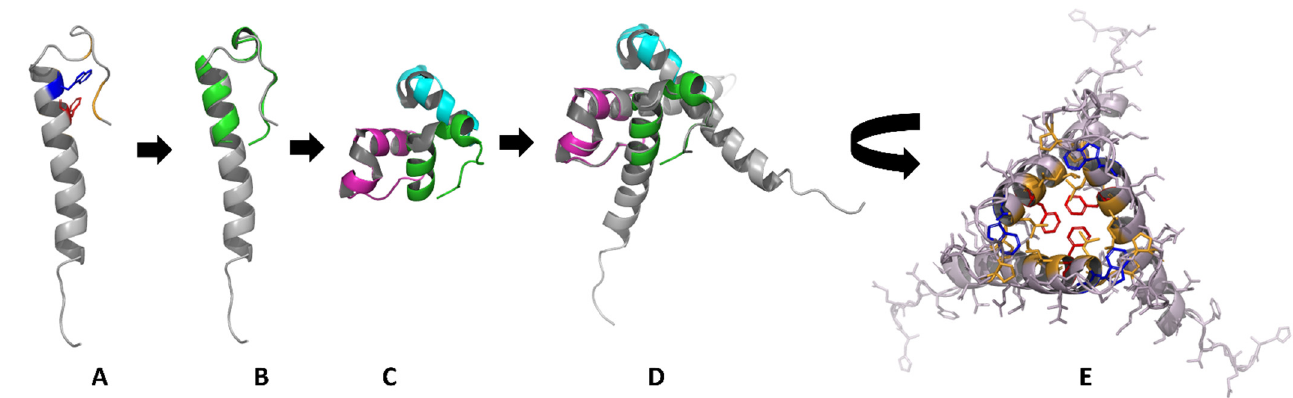
Figure 3. Structural hypothesis on the self-assembly of exendin-4. ( A ) NMR structure of exendin-4 in 30% TFE (PDB 1JRJ) with the conserved hydrophobic domain shown in colors (red Phe22, blue Trp25, orange Pro31, Pro37, Pro38). ( B ) Alignment of exendin-4 (gray) with the X-ray structure of a monomeric subunit of the cyclized Trp-cage miniprotein (PDB 3UC7, green). ( C ) Smallest oligomeric subunit of the cyclized Trp-cage miniprotein found in the crystals is a trimer (Trp-cage miniprotein subunits in the trimer are shown in green, pink and light blue). ( D ) Alignment of exendin-4 monomers (gray) with the trimeric subunit of the cyclized Trp-cage miniprotein (magenta, green and cyan). ( E ) Removal of the cyclized Trp-cage miniprotein trimer and planar projection visualize a structural hypothesis on the molecular nature of an exendin-4 trimer with the hydrophobic domain buried in the oligomer interior (red Phe22, blue Trp25, orange other hydrophobic amino acids).